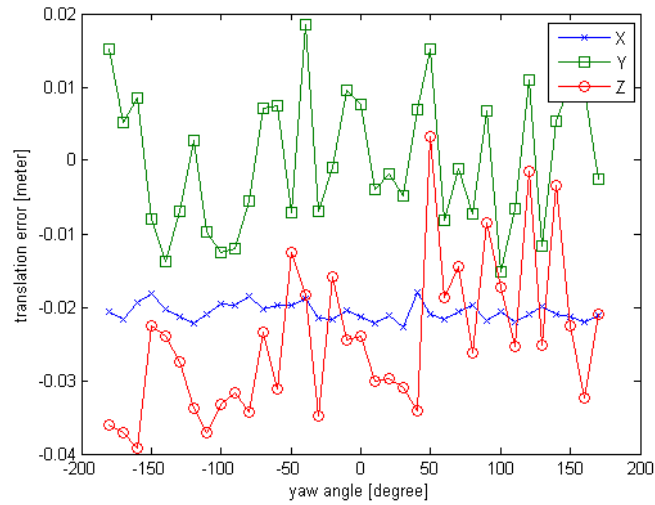
Figure 9. The translation error curve of Experiment 2 for initial pose.